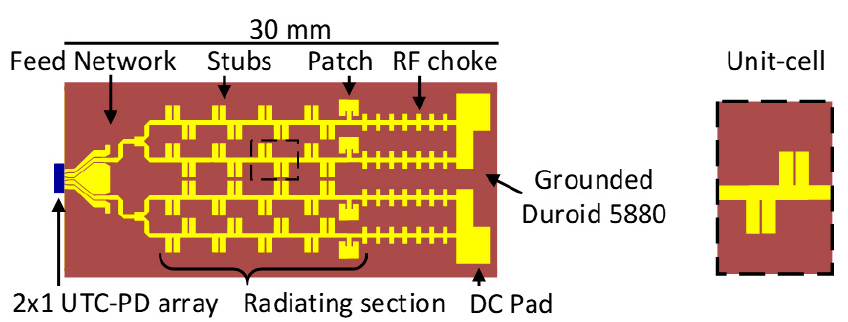
Figure 1. Layout of the designed antenna with the different sections indicated, and unit-cell of the radiating section.